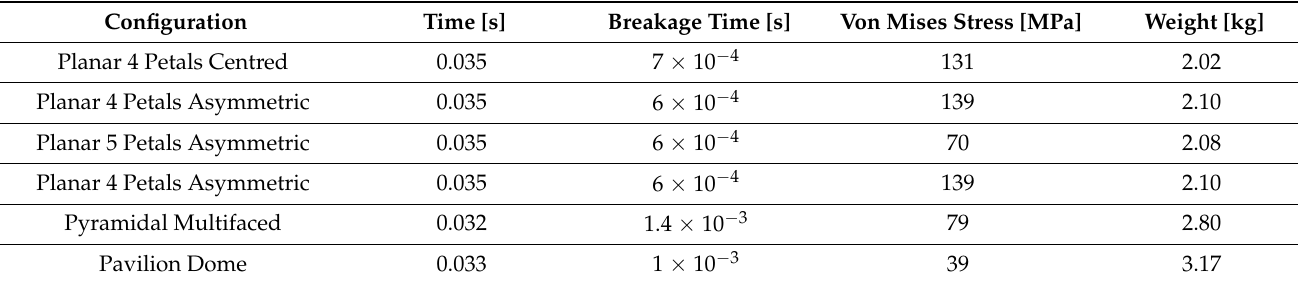
Table 4. Numerical results.